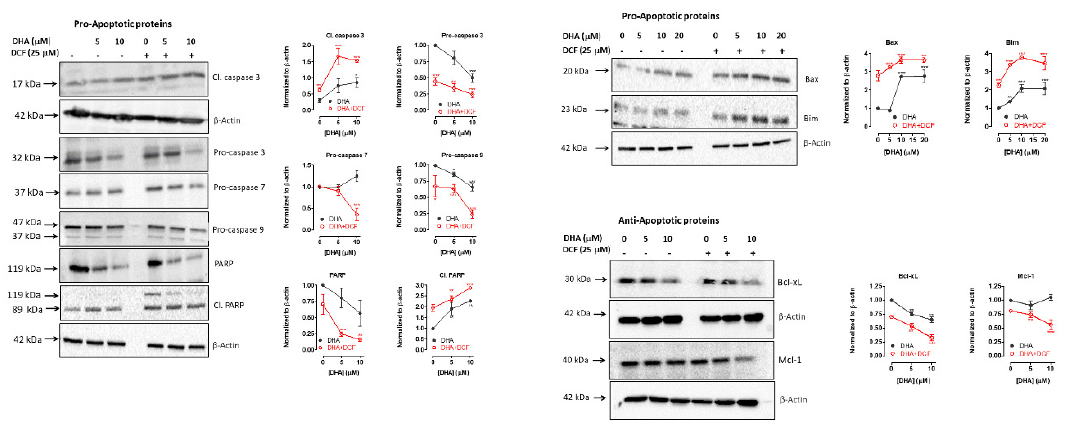
Figure 7. Diclofenac (DCF) and DHA induce the expression of pro-apoptotic proteins. Western blot analysis showing the expression of pro-apoptotic and anti-apoptotic proteins in A549 cells after treatment with DHA (0–10 µ M) and DCF (25 µ M) for 48 h. The blots were quantified using Biorad Image Lab software and analyzed using one-way analysis of variance followed by Bonferroni’s multiple comparison test. Results are from three independent experiments (mean ± SEM, n = 3). * p < 0.05, ** p < 0.01, and *** p < 0.01 compared to control. Detailed information about western blot can be found at Figure S1.